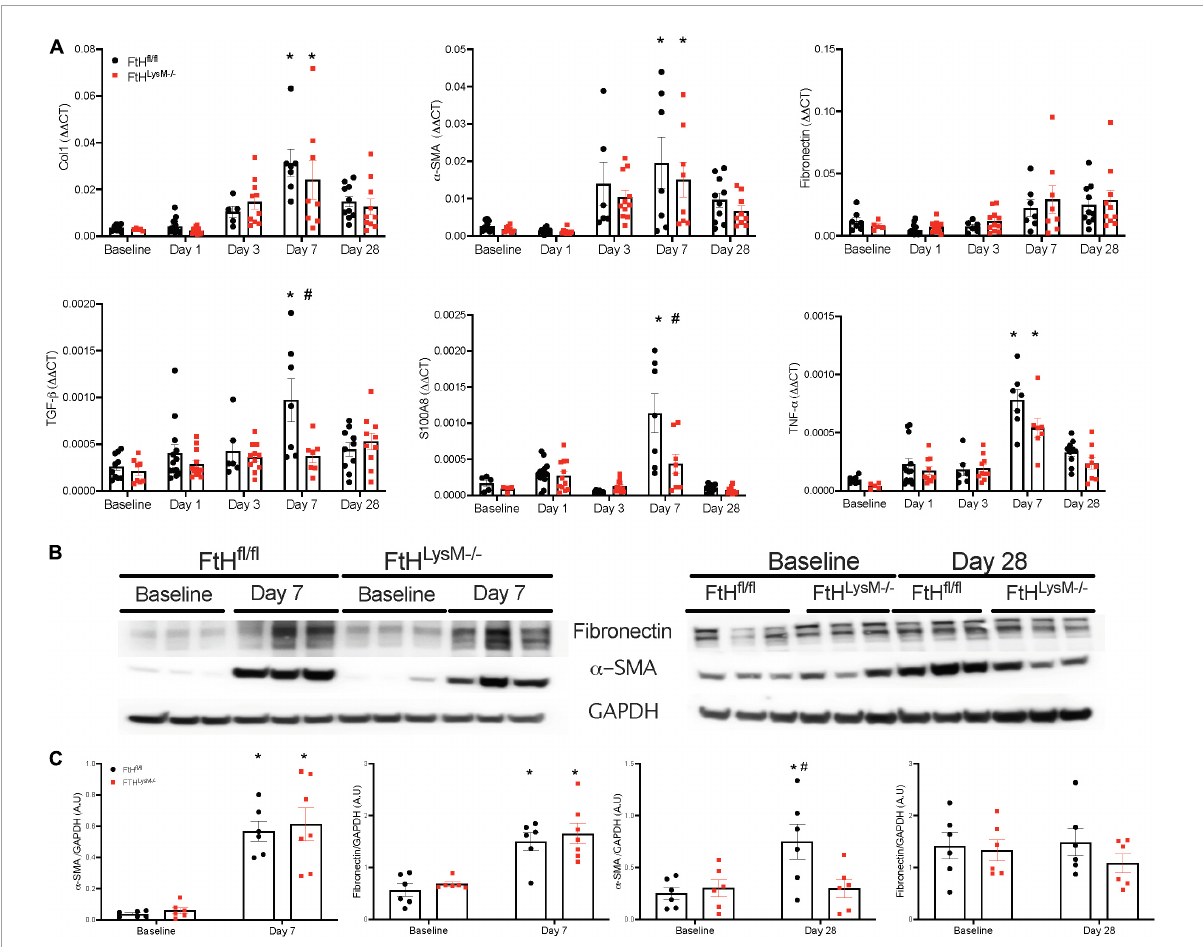
FIGURE6 Myeloid FtH deficiency is associated with reduced expression of fibrosis markers. (A) Kidneys were analyzed for the expression of transforming growth factor- β , collagen 1, fibronectin, α -smooth muscle actin, S100A8, tumor necrosis factor- α by real-time PCR analysis. Each experiment was performed at least two independent times. Results were normalized to GAPDH and presented as mean ± SEM. * p < 0.05 vs. baseline control; # p < 0.05 vs. FtH fl / fl . (B) Whole kidney lysates were analyzed for the expression of fibronectin and α -smooth muscle actin by western blot analysis. (C) Expression of the indicated proteins in the kidneys was analyzed by densitometry, normalized to GAPDH and expressed as mean ± SEM. * p < 0.05 vs. baseline control; # p < 0.05 vs. FtH fl / fl